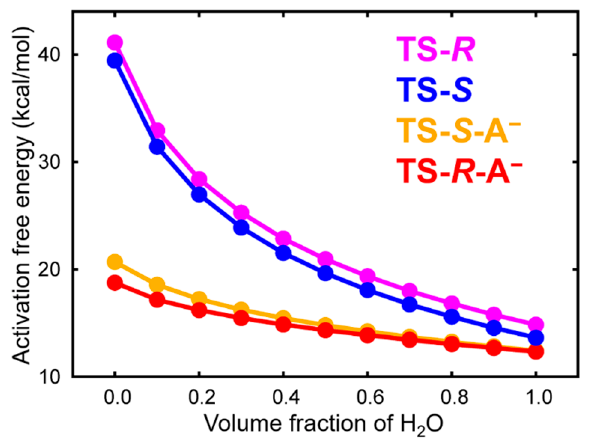
Figure 3. Calculated activation free energies with respect to volume fraction of H 2 O. The activation free energies of TS- R -A − , TS- S -A − , TS- R , and TS- S are shown in red, orange, purple, and blue lines, respectively.